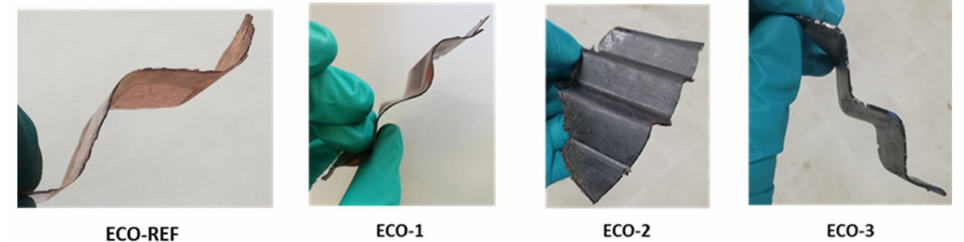
Figure 5. Reprocessed materials after 10 min at: 150 ◦ C (ECO-1 and ECO-REF); 180 ◦ C (ECO-2), and 200 ◦ C (ECO-3).